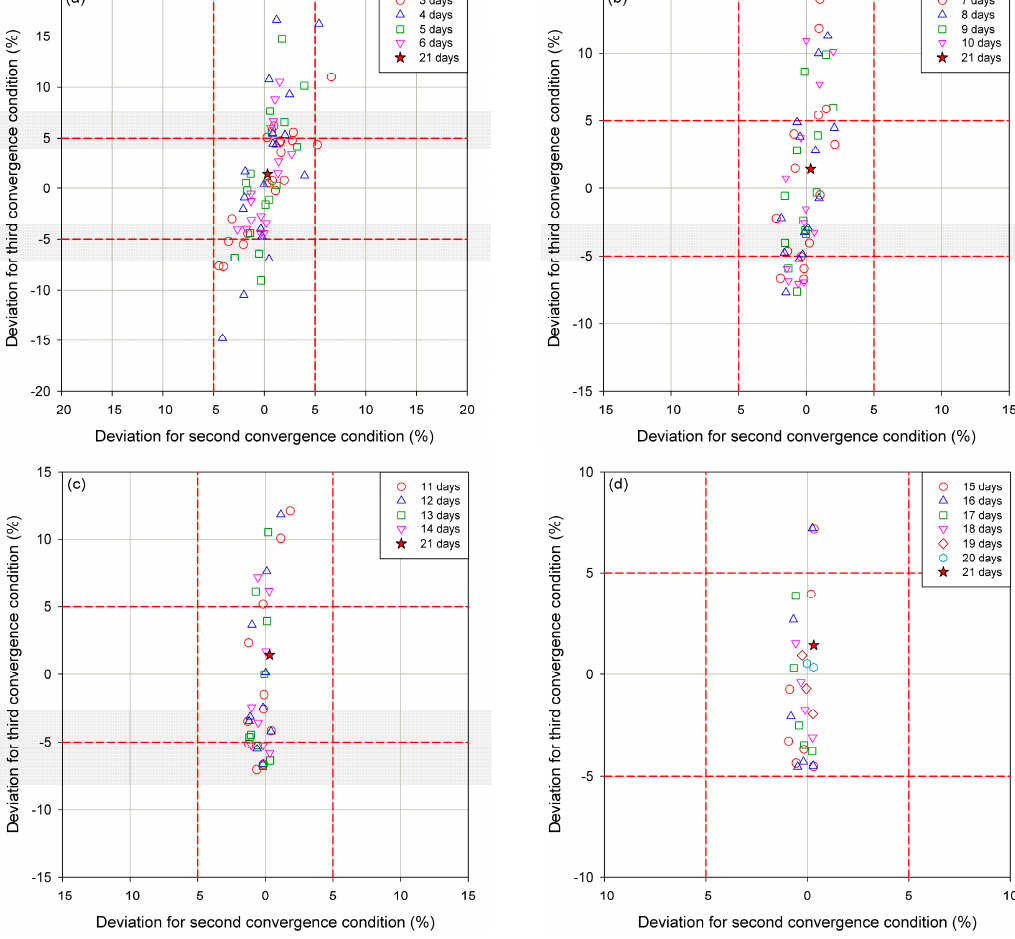
Figure 6. Convergence characteristics of R -values evaluated for different analysis periods according to conditions of the ISO 9869-1 standard. For ease of understanding, the plots are divided into four sub-figures based on the length of the analysis period: ( a ) 3–6 days; ( b ) 7–10 days; ( c ) 11–14 days; ( d ) 15–20 days.